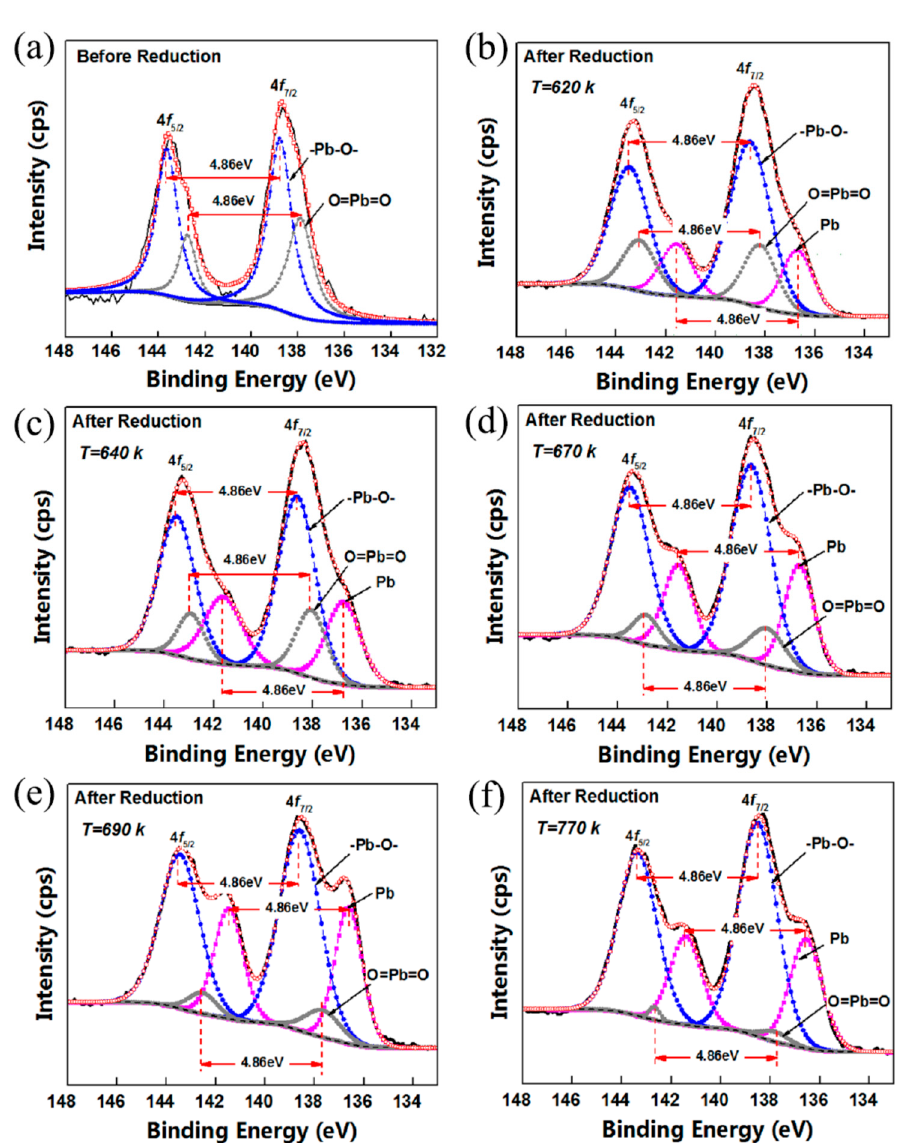
Figure 4. XPS spectra of Pb4f before and after reduction. ( a ) Before reduction; ( b – f ) after reduction; ( b ) T r = 620 K, ( c ) 640 K, ( d ) 670 K, ( e ) 690 K and ( f ) 770 K, respectively; the binding energy differences between Pb 4f 7/2 and Pb 4f 5/2 of Pb 0 , Pb–O and O=Pb=O were set as 4.86 eV in the peak-fit processing according to the ”handbook of X-ray photoelectron spectroscopy” [22], the [Pb] ”shoulder” peaks were observed in the XPS spectrum after reduction.